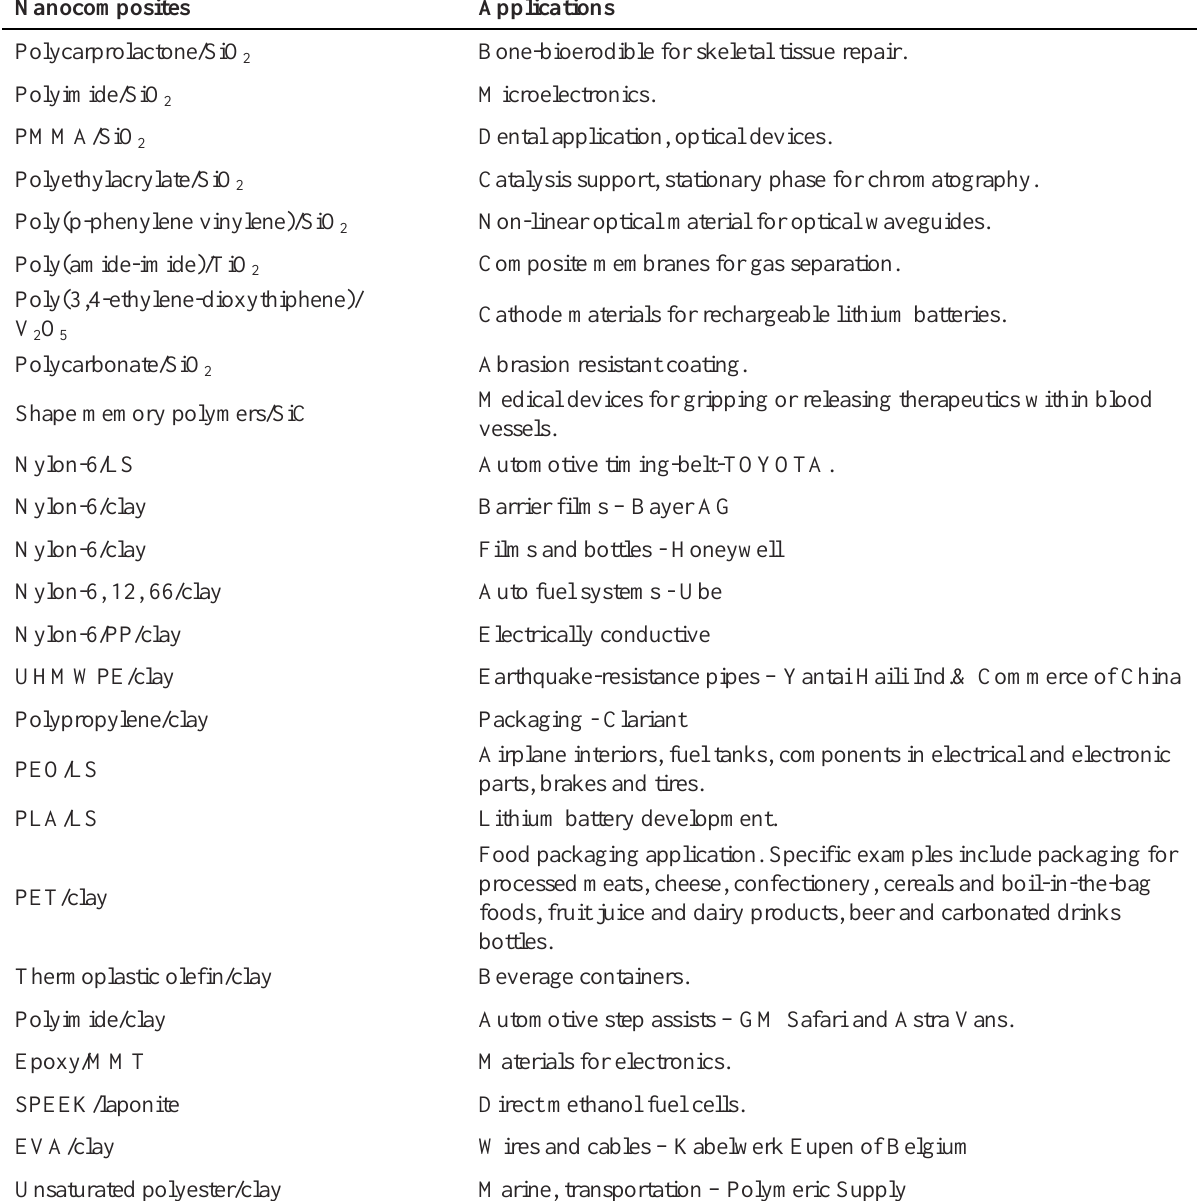
Table 3. Potential applications of polymer-based inorganic nanoparticle nancomposites (adapted from Refs. [4] and